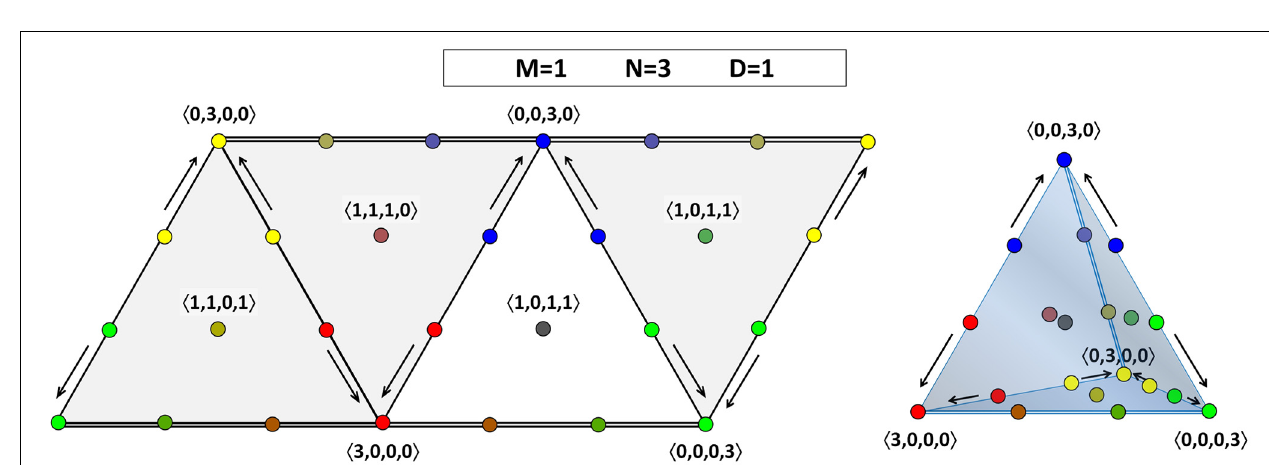
edge (connecting profiles with a consensus on “more distant” theories—see the main text for details) show a different dynamics than those on the two “single” edges. For D = 2 (right), the three vertices act as sinks, and the asymmetry between points on the edges is removed.